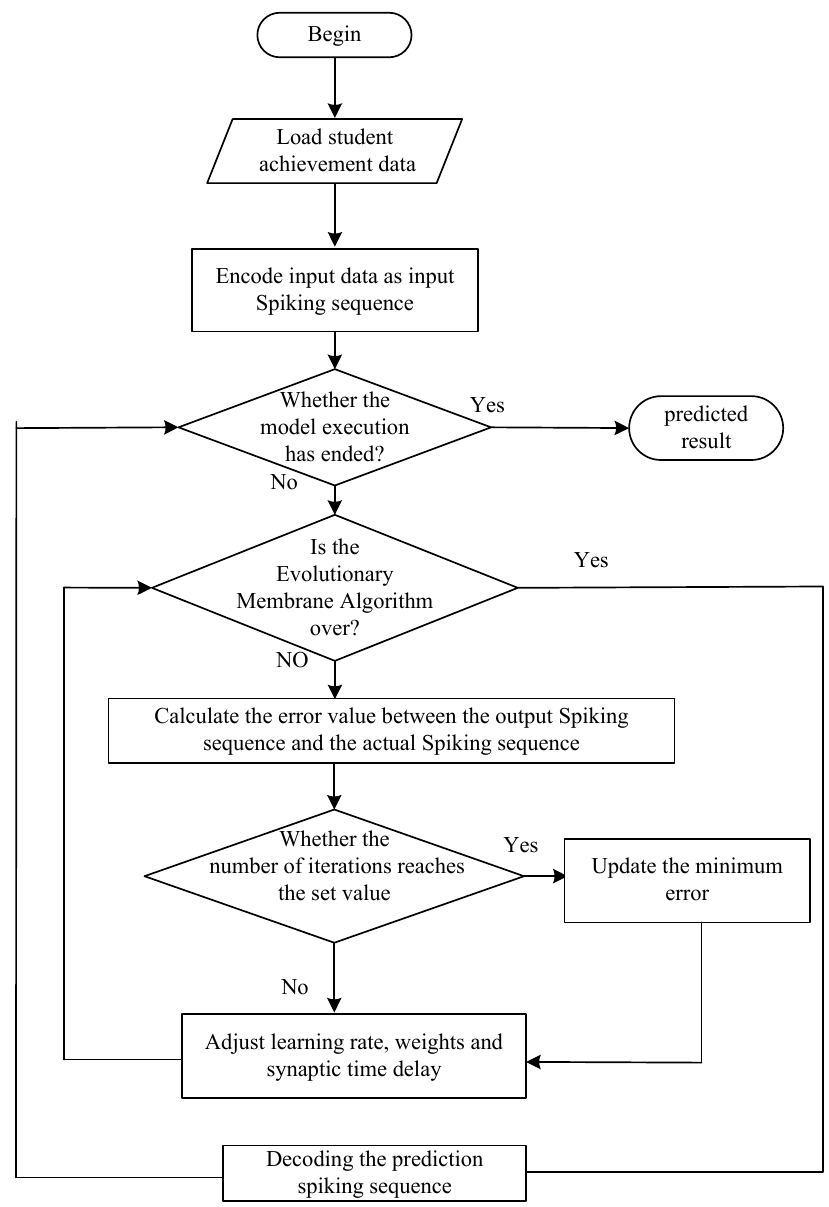
Figure 3. Flowchart of Student Achievement Prediction